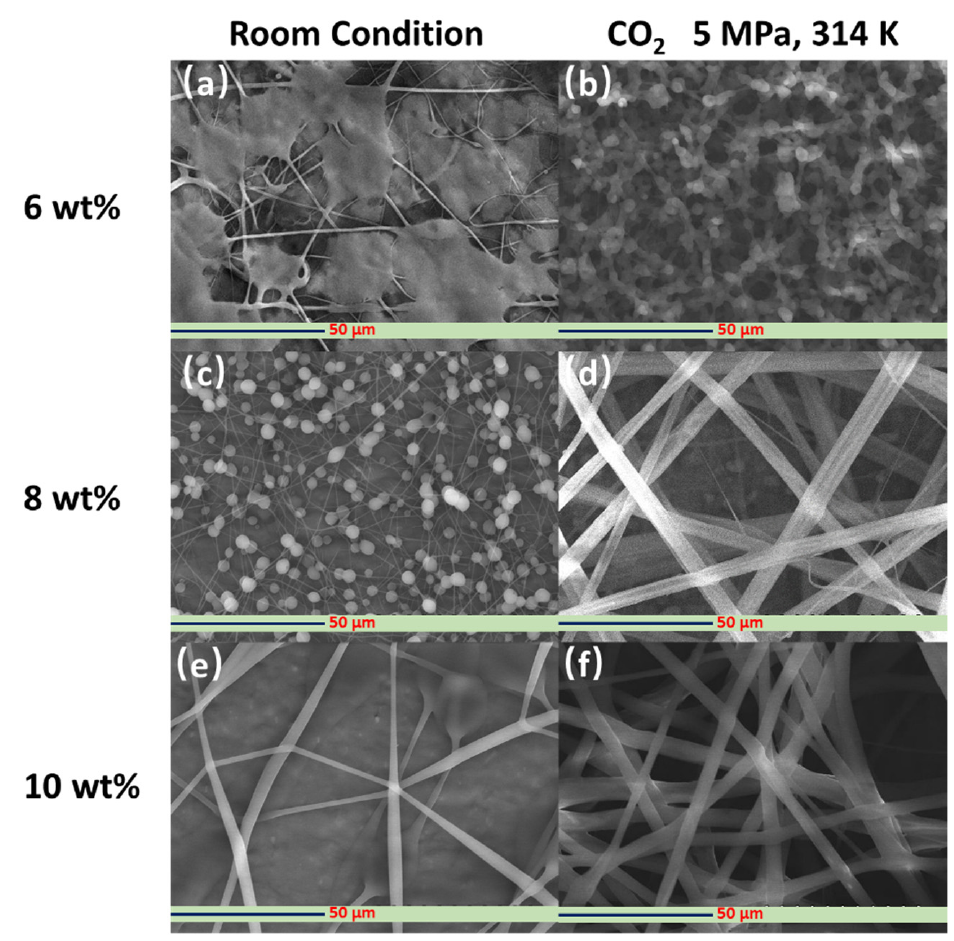
Figure 6. SEM images of the PVP fibers fabricated with ( b , d , f ) and without ( a , c , e ) dense CO 2 at 15 kV at different PVP concentrations (6, 8, and 10 wt%).